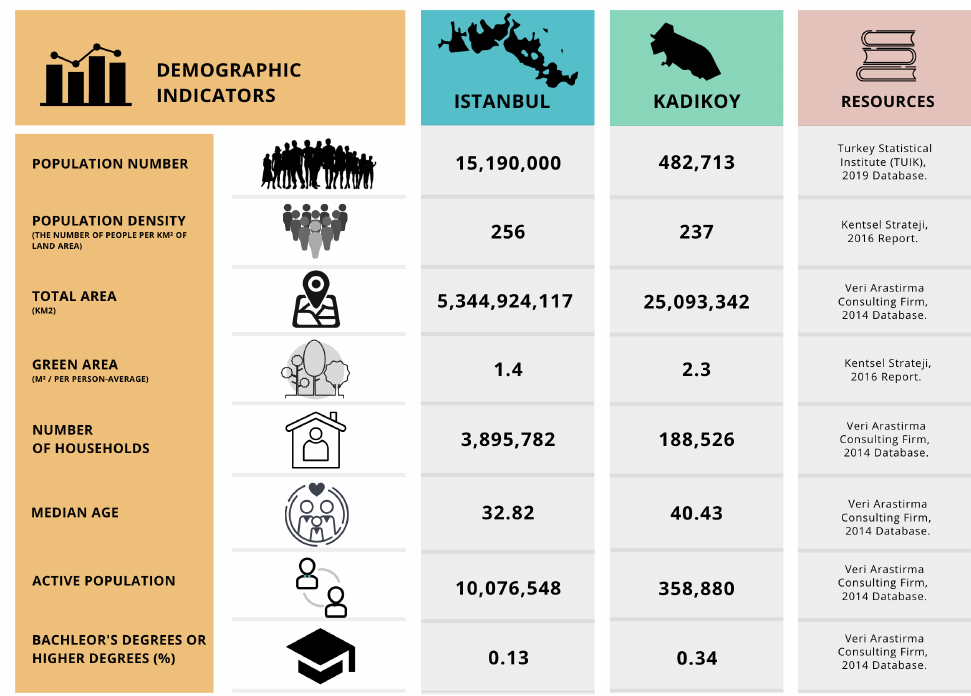
Figure 3. Demographic Indicators of Case Study Area (Figure was produced based on demographic databases of Turkey Statistical Institute (TUIK) (2019) [54] and Veri Arastirma Consulting Firm (2014)